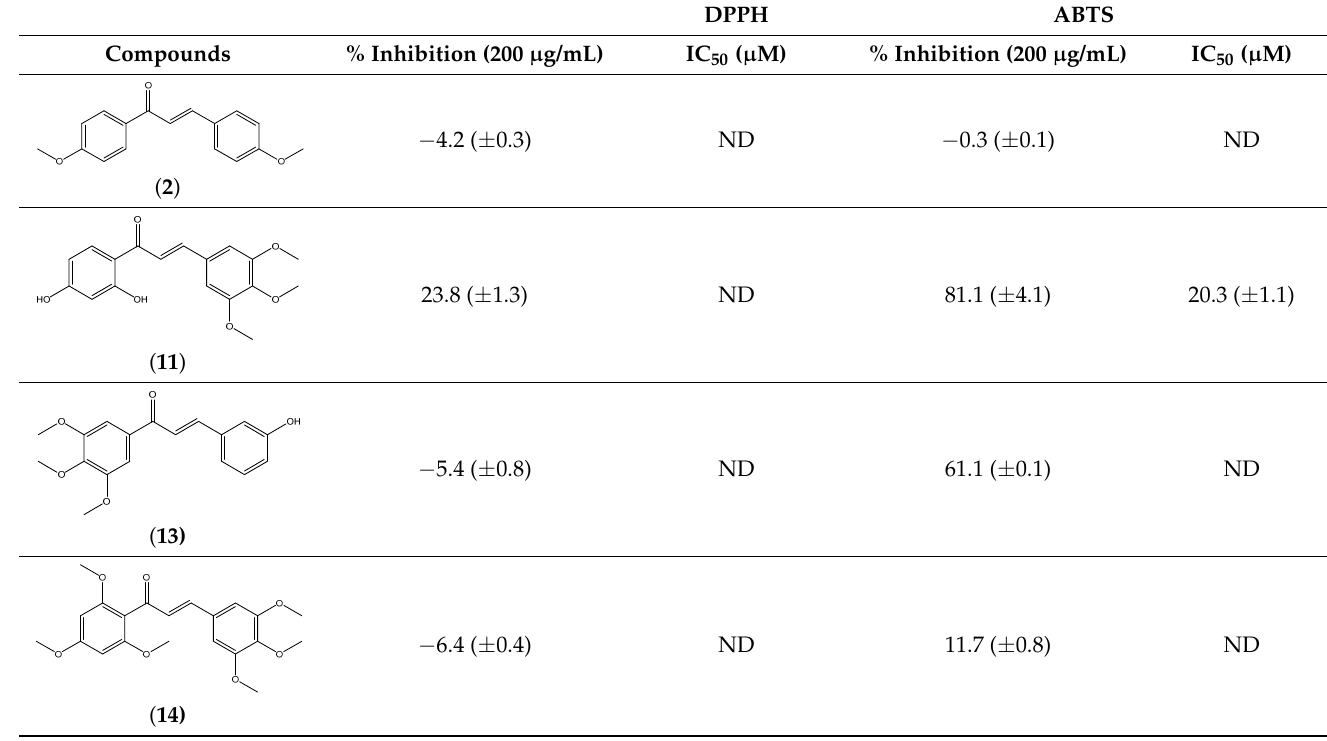
Table 2. Free-radical-scavenging properties against DPPH and ABTS of selected compounds. DPPH ABTS Compounds % Inhibition (200 µ g/mL)